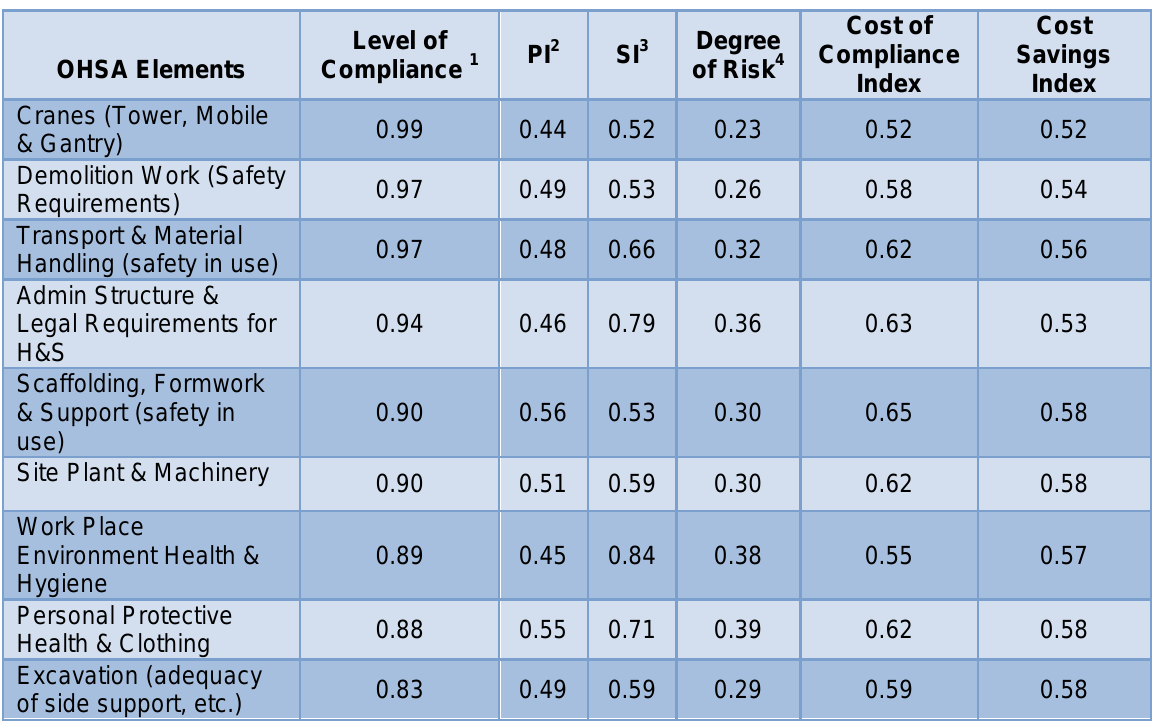
Table 3 Breakdown of detailed scores/indices for variables used in the